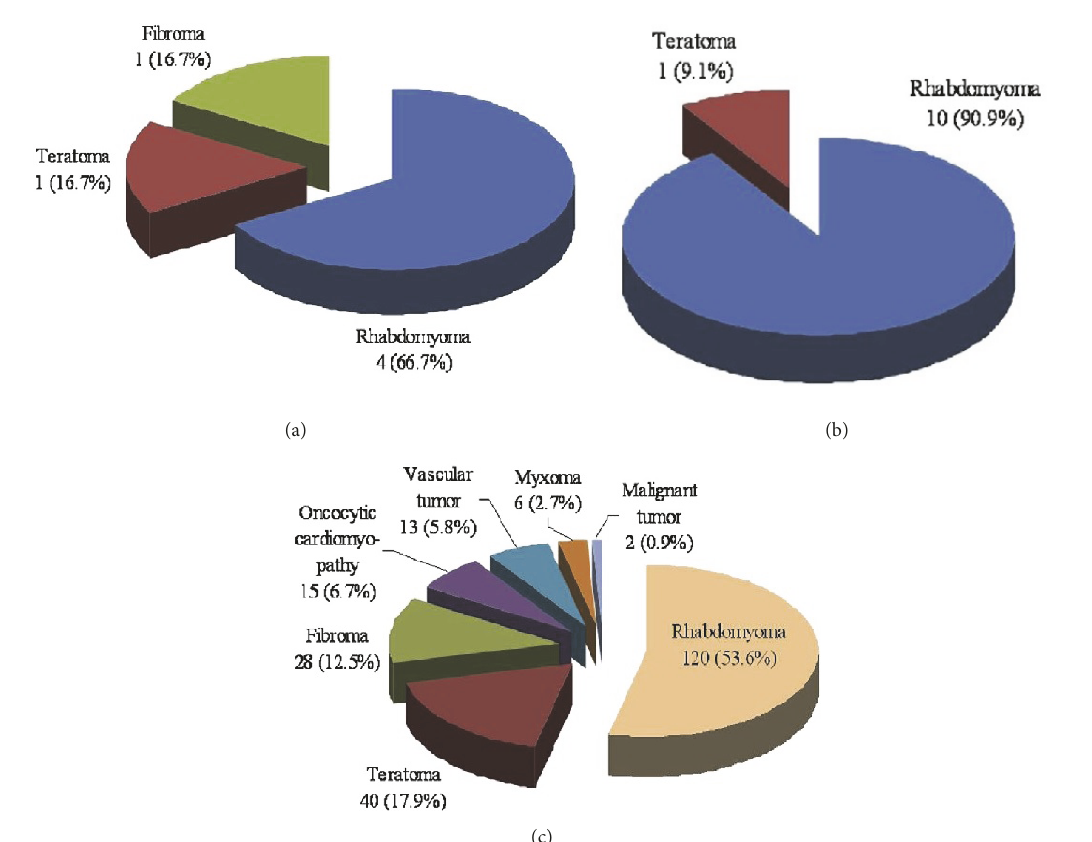
Figure 7: Incidences of primary cardiac tumours in (a) fetal [8], (b) fetal [9], and (c) fetoneonatal groups [9].